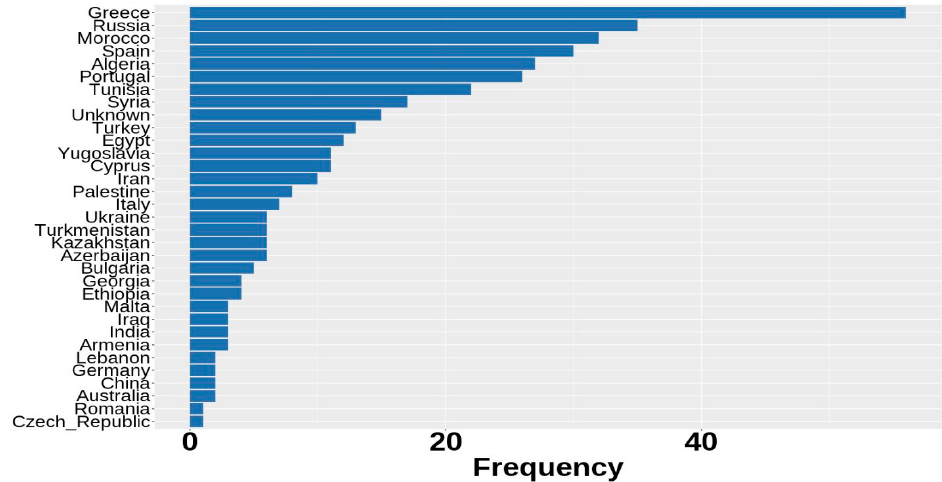
Figure 1. Geographical distribution of accessions used in the current study.